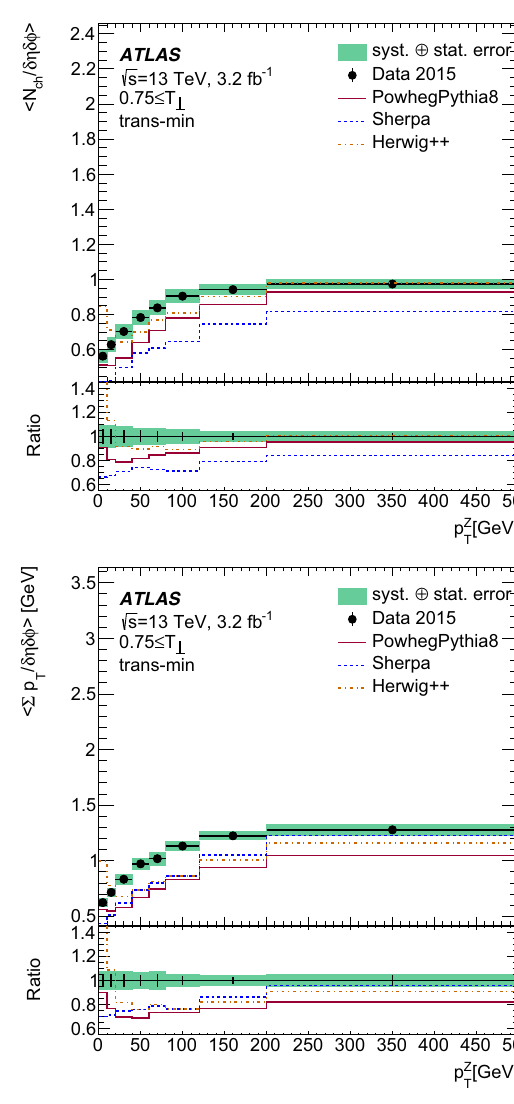
Powheg + Pythia , Sherpa , and Herwig++ are compared with the for T ⊥ < 0 . 75 T